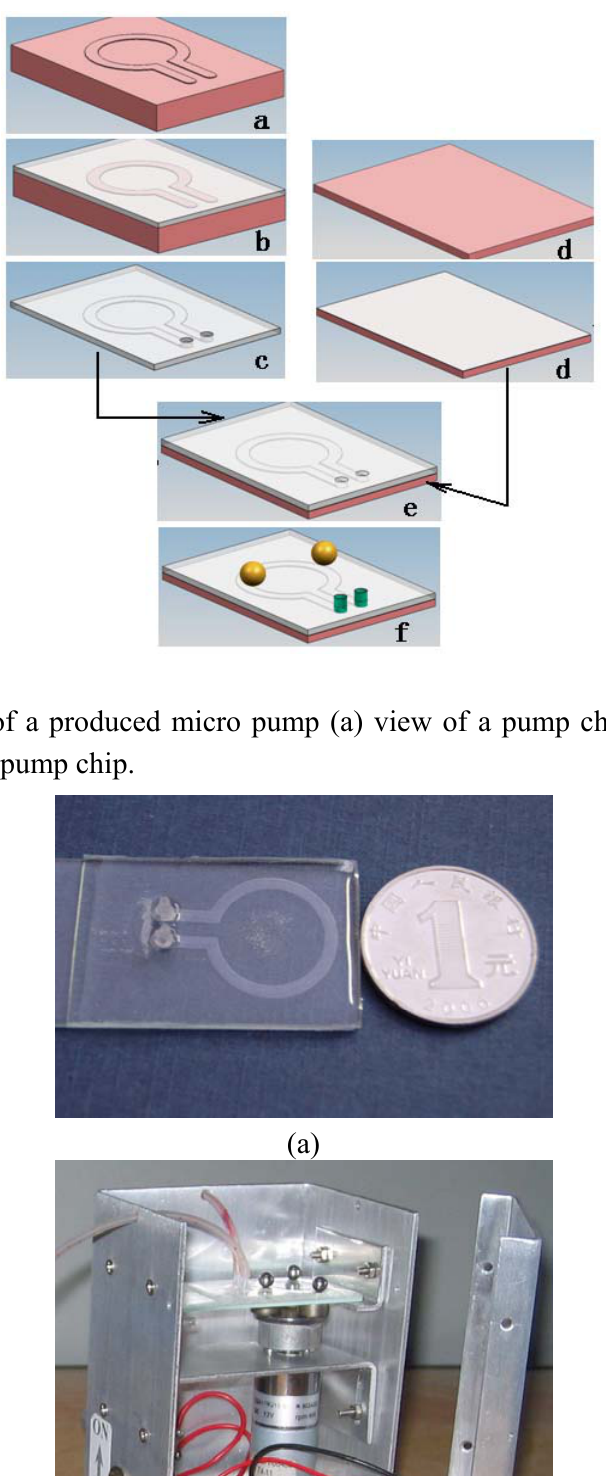
Figure 2. Flowchart of fabrication process, using the PDMS soft lithography technique.